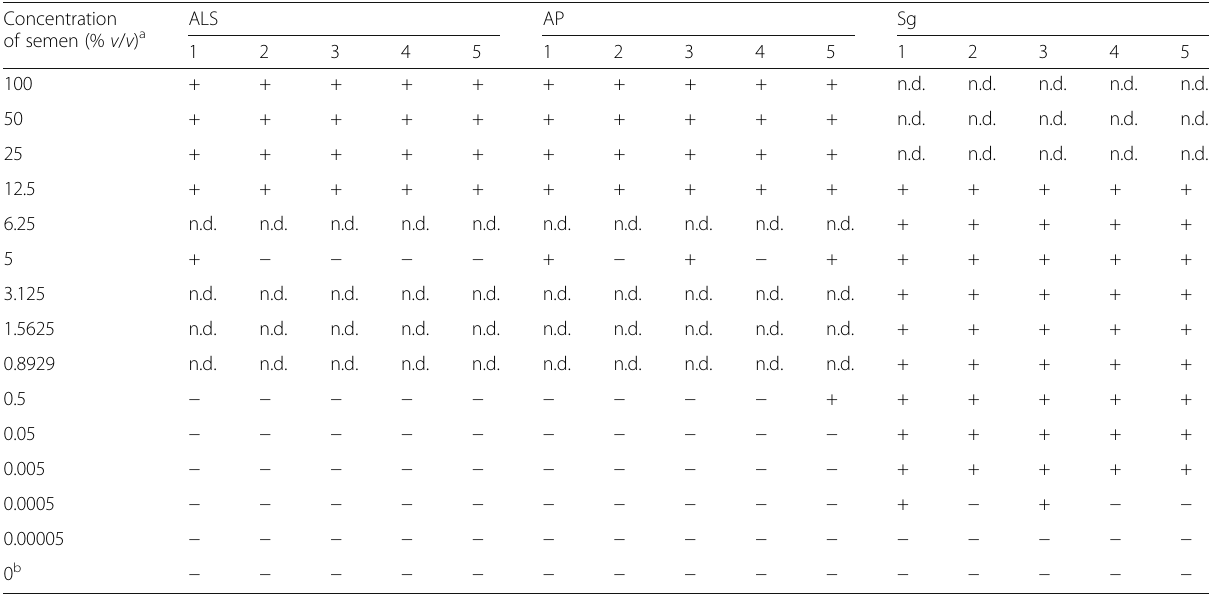
Table 1 Sensitivity of three semen detection tests. Positive or negative scores are shown for each donor (males 1 – 5) Concentration of semen (% v / v )